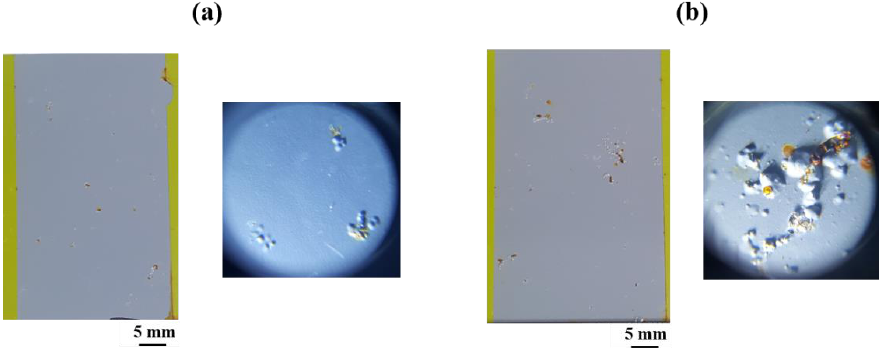
Figure 12. Surface appearance of ED-treated ( a ) AlSi-MC and ( b ) AlSiZnMg-MC, which had been collided with fine stone chips, after the accelerated corrosion test.